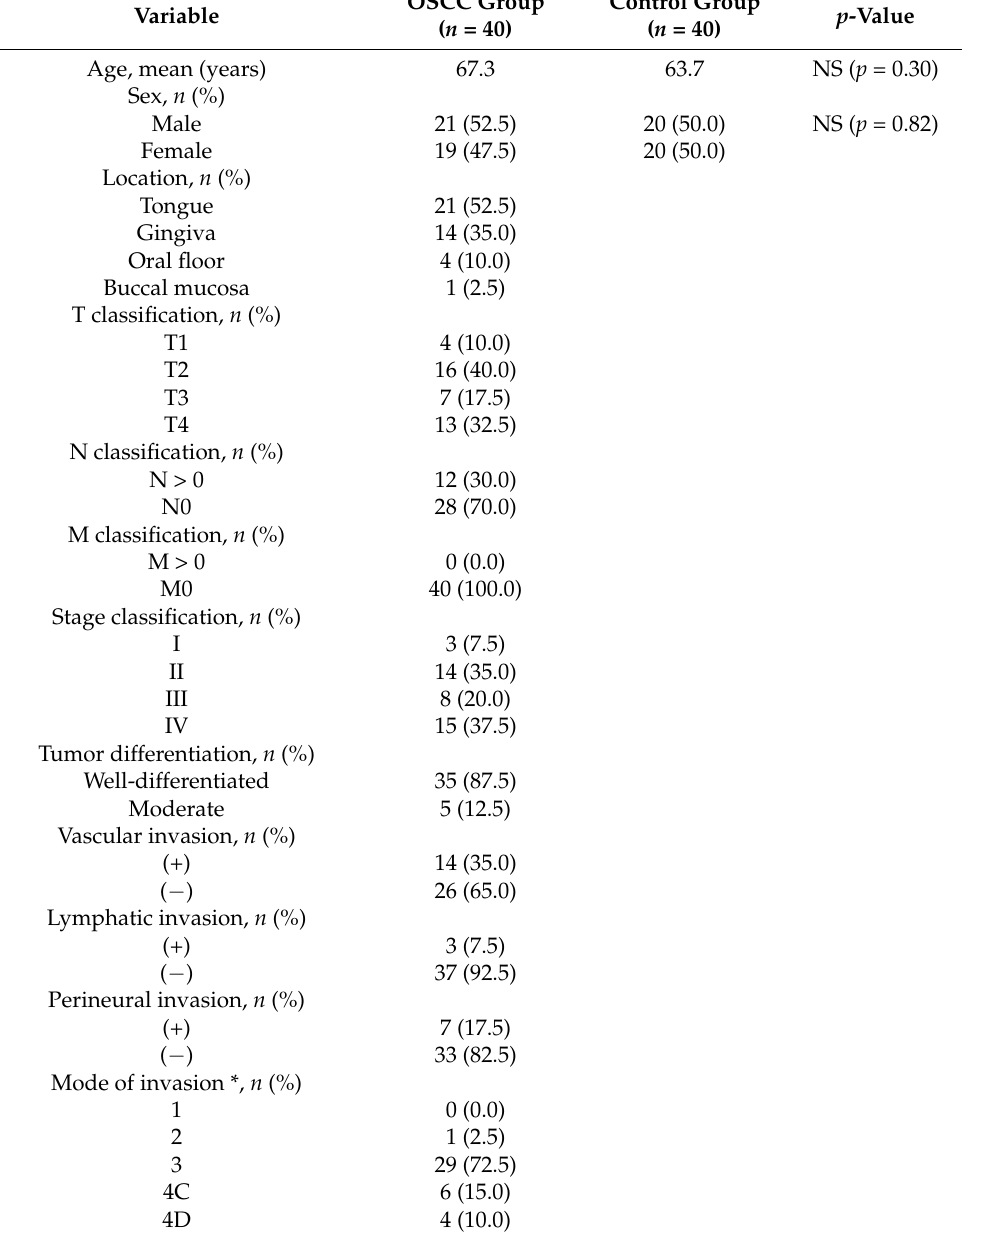
Table 1. Clinicopathological characteristics of study